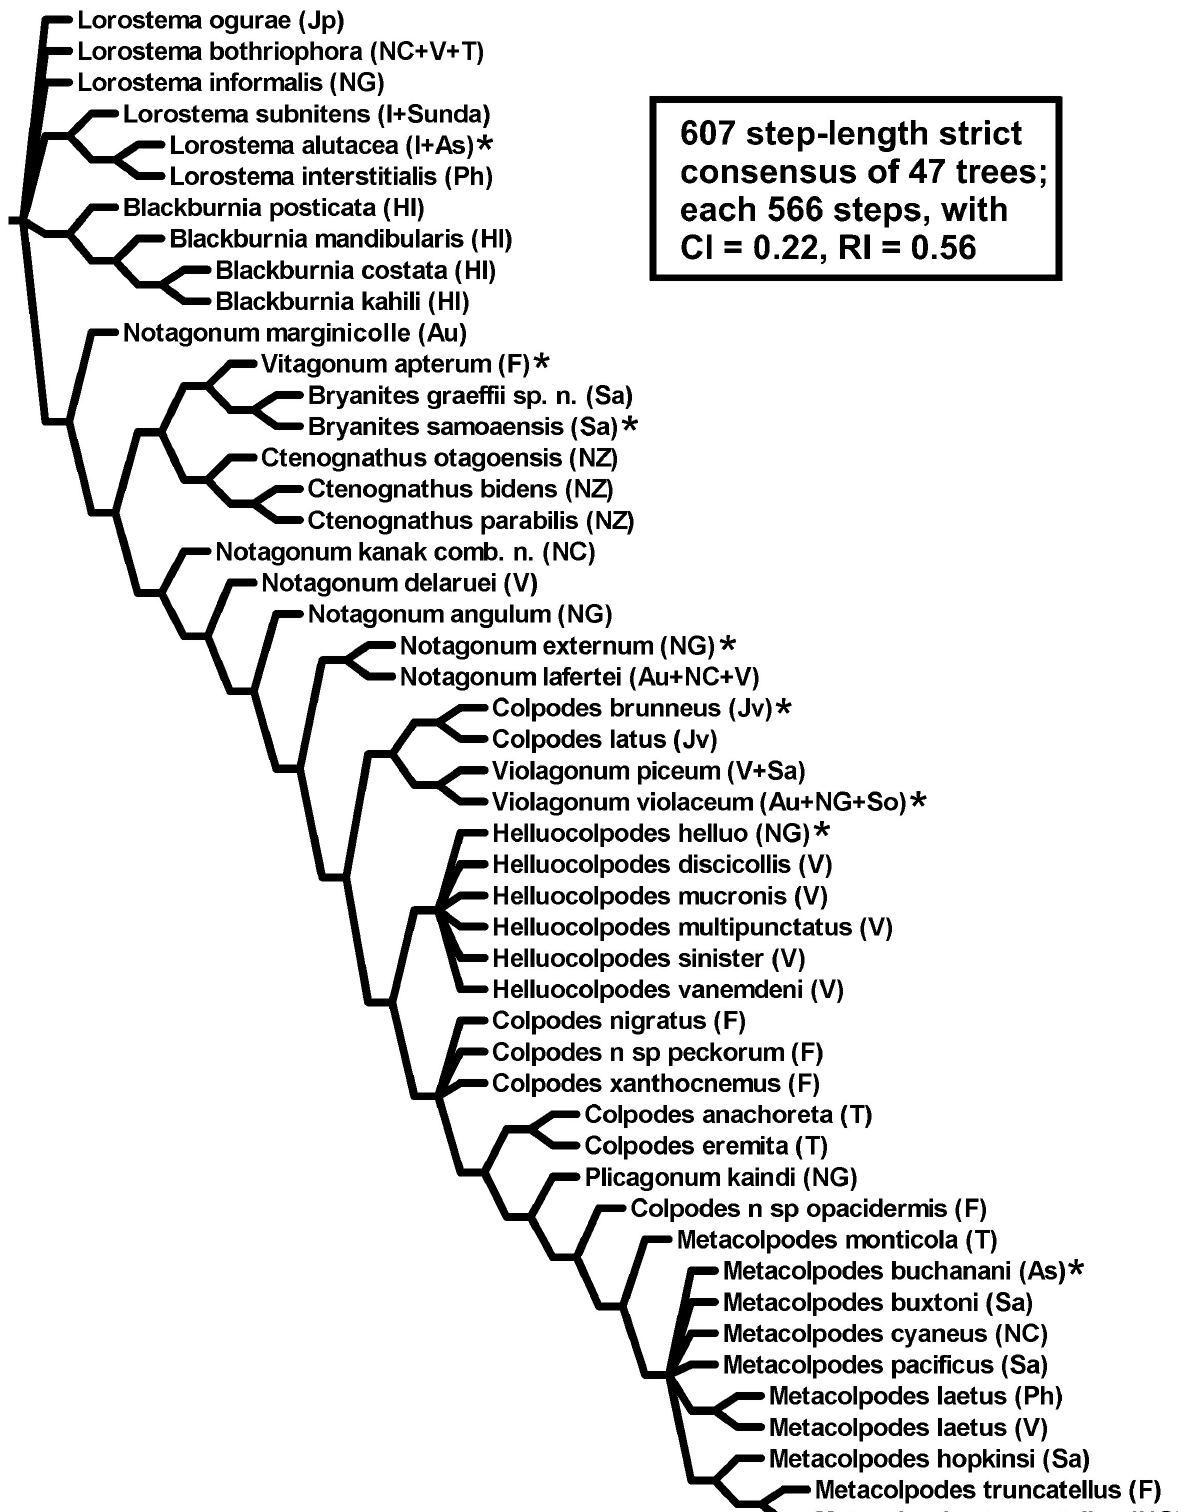
Figure 3. Strict consensus cladogram of 49 taxa of Pacific platynine carabid beetles. Type species, where included, indicated by as - terisks. See text for further explanation of cladistic analysis. Distributional areas of species include: As, Asia; Au, Australia; F, Fiji; HI, Hawaiian Islands; I, India including Sri Lanka; Jp, Japan; Jv, Java; NC, New Caledonia; NG, New Guinea; NZ, New Zealand; Ph, Philippine Islands; R, Rapa; Sa, Samoa; So, Solomon Islands; Sunda, Sunda Islands; T, Tahiti and Society Islands; V,